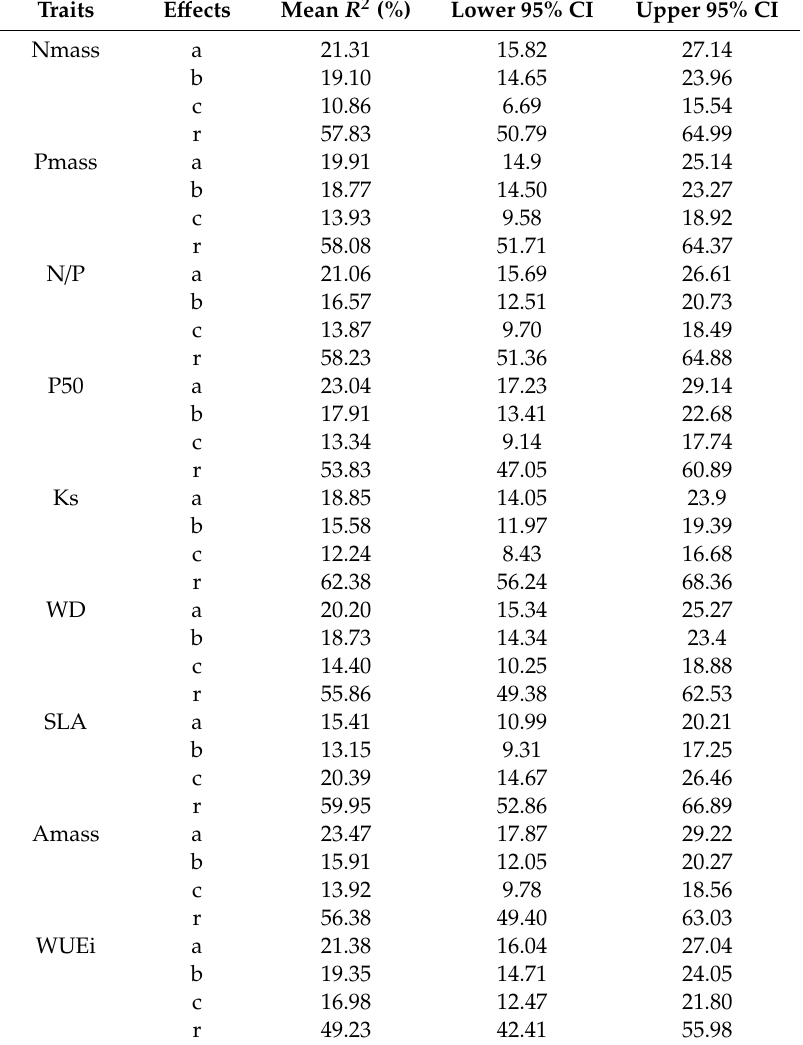
Table A3. Bootstrapping mean pure and shared e ff ects of SW (dry season soil water content in the top 50 cm layer) and BA (basal area) on quadrats’ trait value changes as derived from variation partitioning analysis and bootstrapping